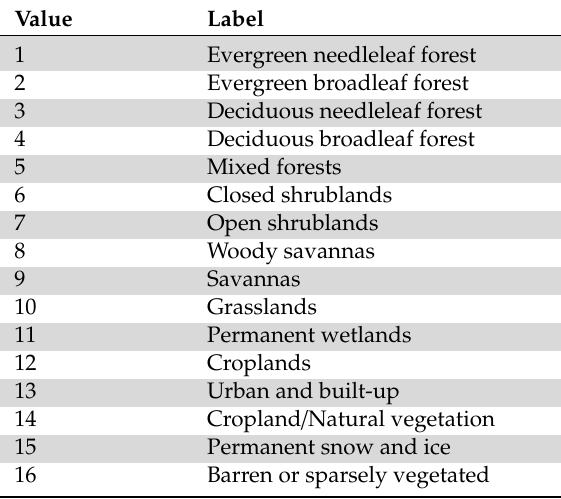
Table A1. The names of the land cover